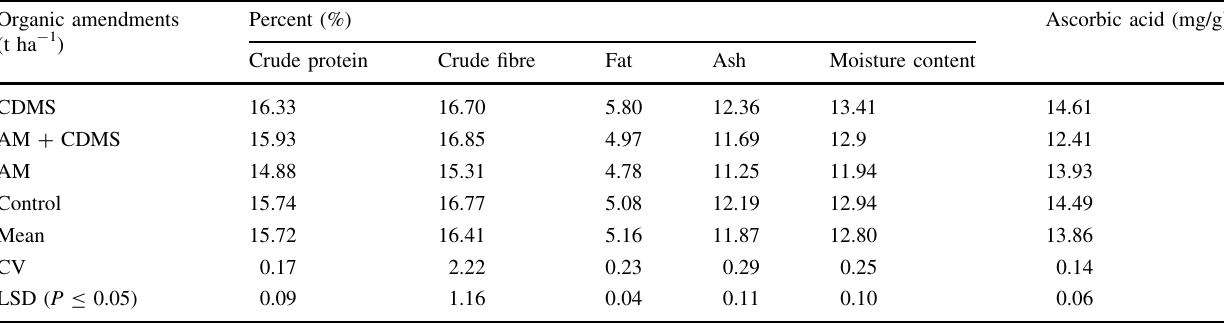
Organic amendments (t ha - 1